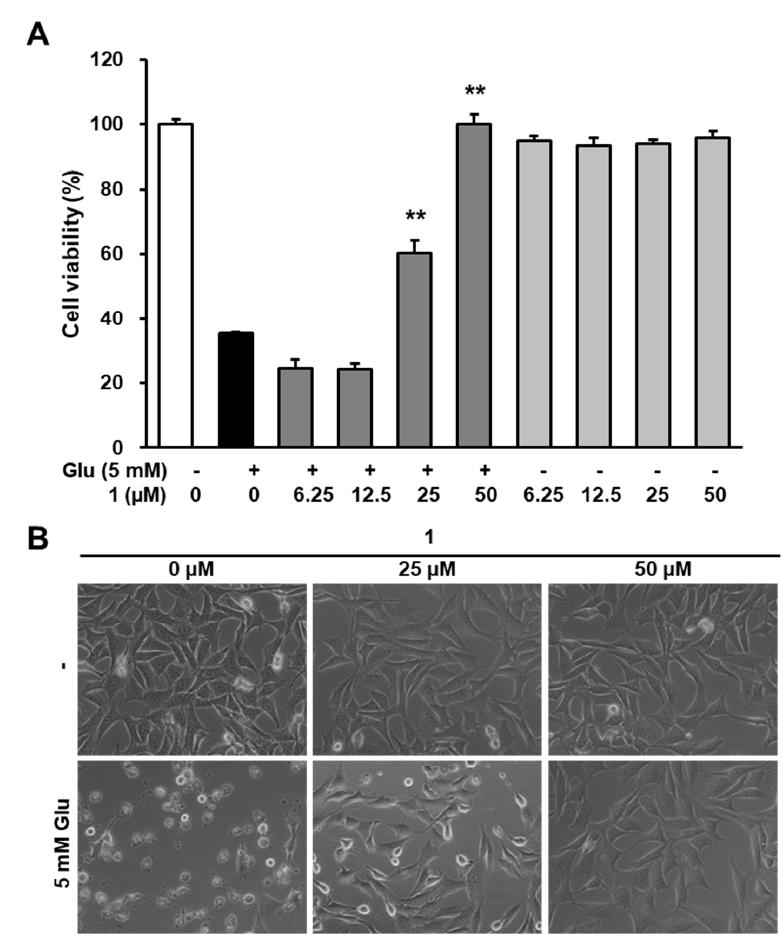
Figure 3. Compound 1 prevents HT22 cell death induced by glutamate. (A) The cells were exposed to 5 mM glutamate and the indicated concentrations of 1 for 24 h. The cell viability was determined using an EZ-CyTox cell viability assay kit. Bars denote the percentage of viable cells (** p < 0.001 compared with the glutamate-treated group). (B) Morphological changes were represented by microscopic images (40×).